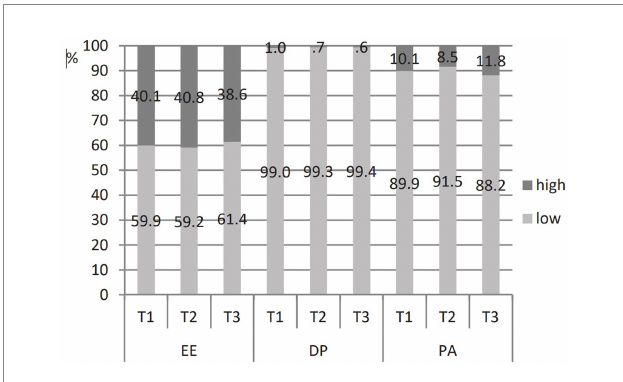
FIGURE 1 Percentage of teachers with high and low burnout dimensions at three time